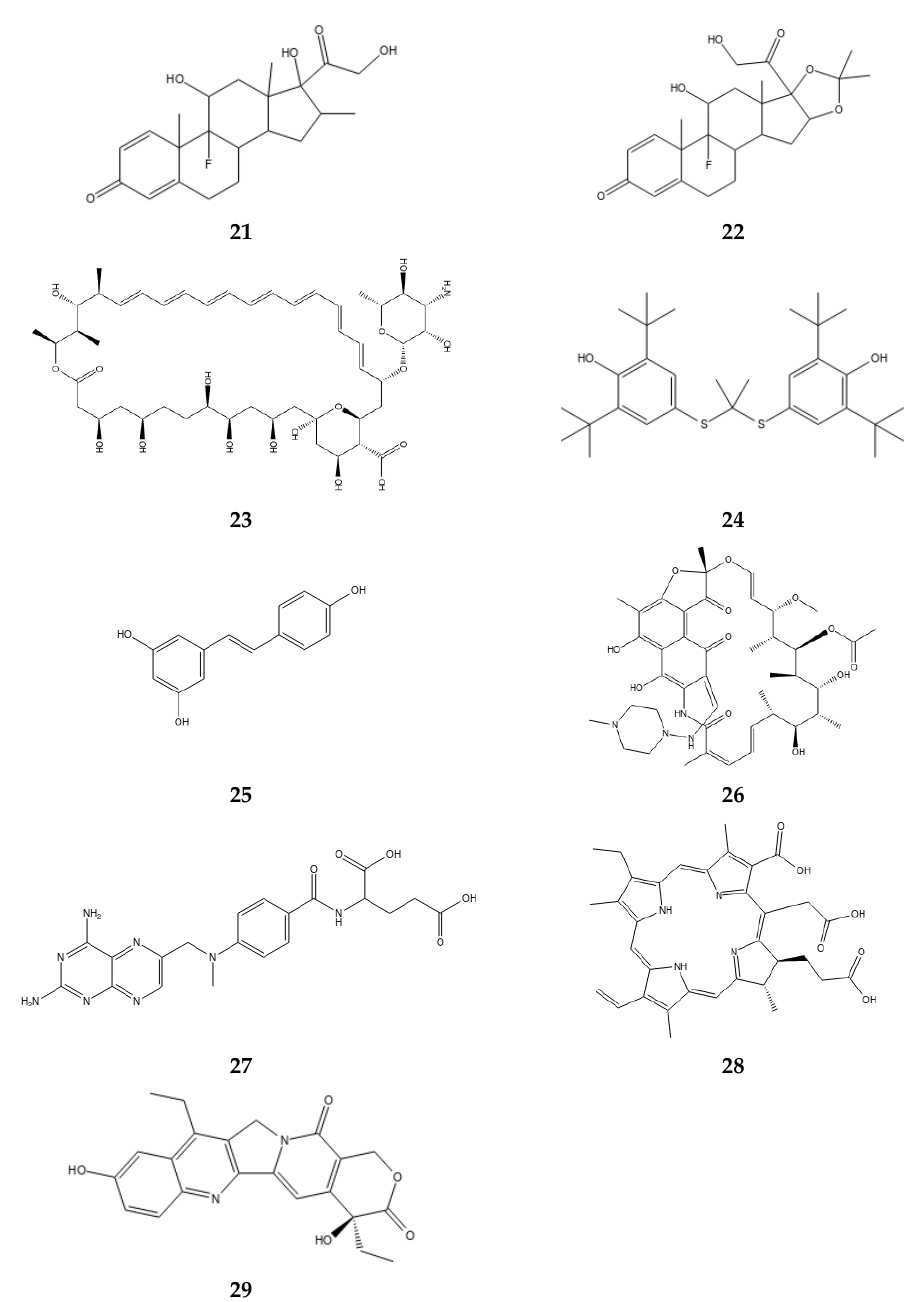
Figure 5. Some of the small molecules of which PAMAM dendrimer has enhanced their solubility and other desirable properties for site specific delivery in pre-clinical and clinical trials. These molecules were investigated using experimental and/or computational